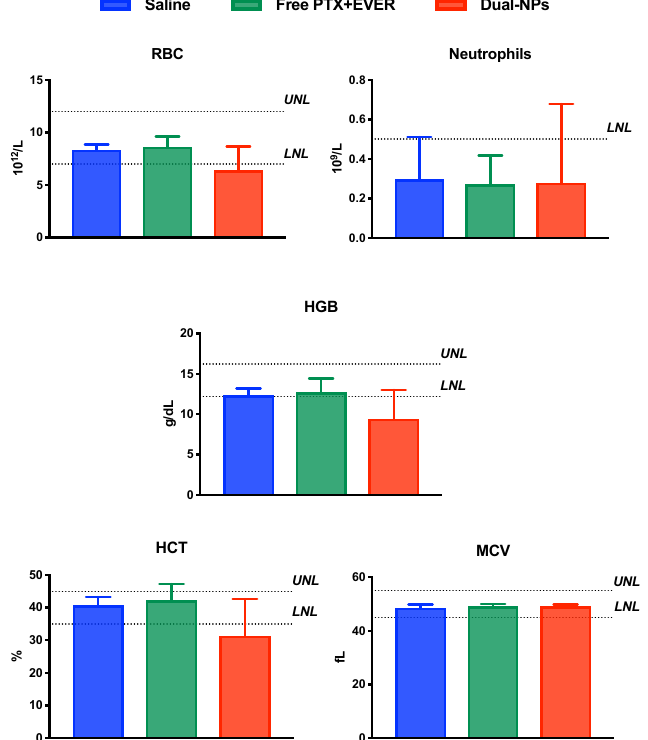
Figure 6. Red blood cell count (RBC), neutrophil count, hemoglobin concentration (HGB), hematocrit (HCT) and the mean corpuscular cell volume (MCV) in mice 2–3 days after receiving saline (blue), free paclitaxel and everolimus (PTX + EVER) (green), and dual-targeted PTX + EVER-loaded nanoparticles (Dual-NPs) (red) weekly for six weeks at a PTX-equivalent dose of 15 mg / kg. Data represent mean ± SD ( n = 5–8).